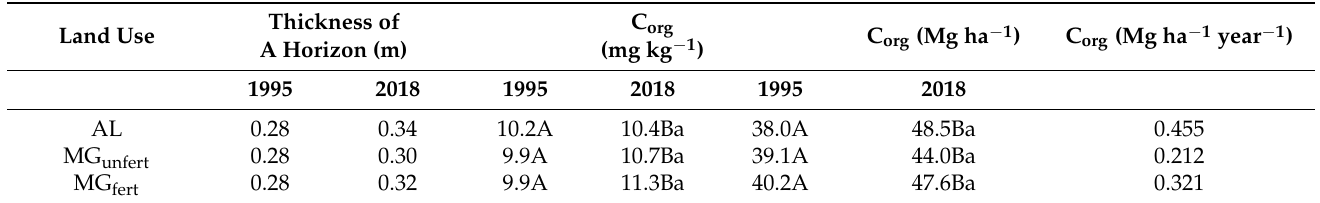
Table 3. Organic carbon accumulation in the A horizon of soils under different land uses. Land